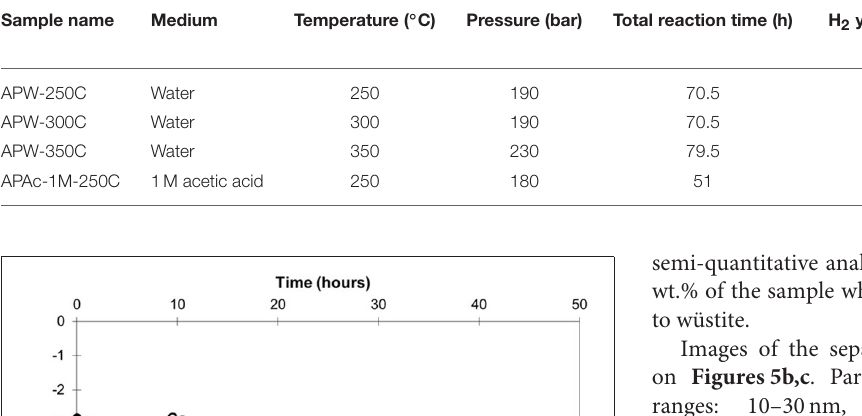
TABLE 3 | Experimental conditions and measured H 2 yield in experiments performed in the sampling autoclave.